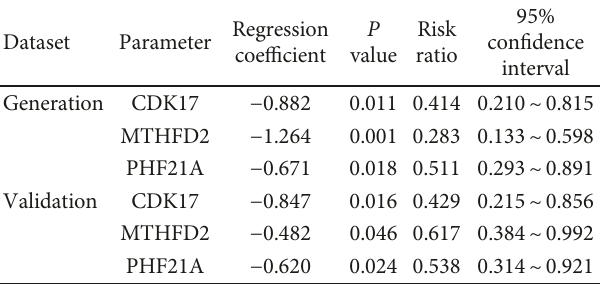
Table 4: Cox multivariate analyses of biomarkers associated with OS in the generation and validation